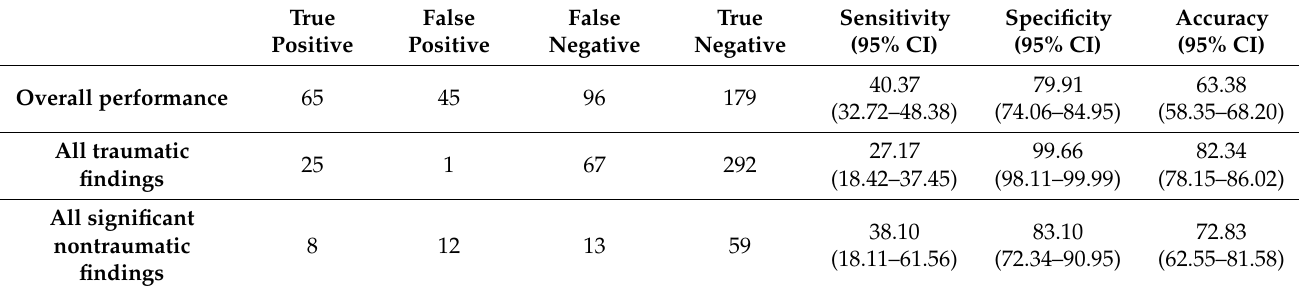
Table 3. Performance of original C-spine CT report in the identification of thoracic inlet abnormalities using re-interpretation as a reference